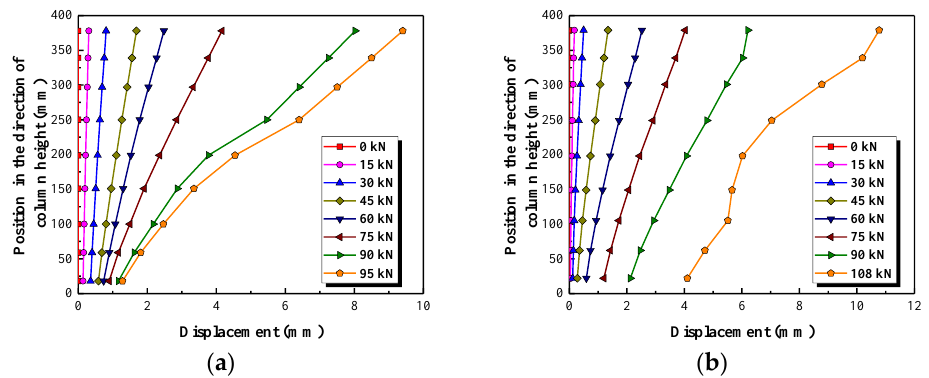
Figure 14. The lateral displacement of the columns obtained by DIC. ( a ) Test specimen G1; ( b ) Test specimen S1.